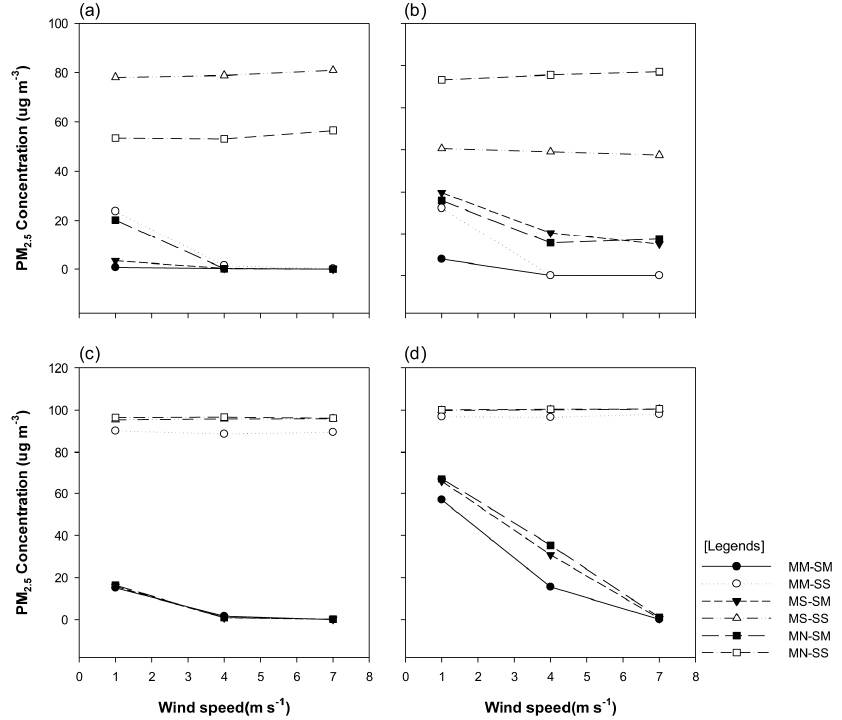
Figure 10. Graphs portraying the particulate matter (PM 2.5 ) concentration at each site, based on the changes in the wind velocity for diagonal wind flow direction (45): ( a ) pedestrian road (P-1), ( b ) leeward motor road (P-2), ( c ) windward motor road (P-3), and ( d ) windward pedestrian road (P-4). 3.2. Changes in Particulate Matter (PM 2.5 ) Concentration According to Wind Direction